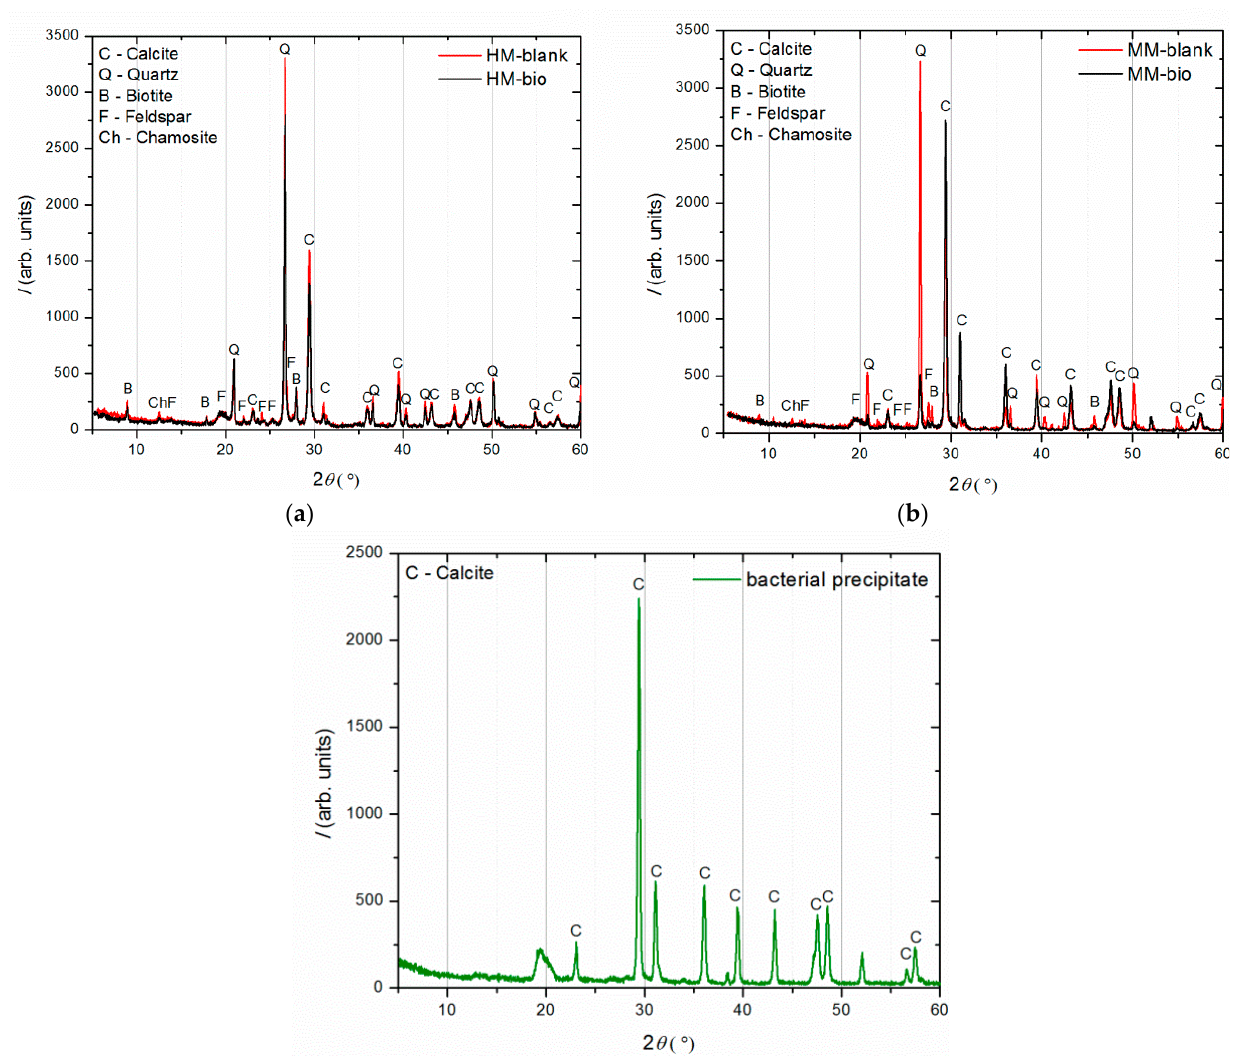
Figure 11. XRD analysis after 150 days of incubation: ( a ) HM blank and HM bio-samples comparative results, ( b ) MM blank and MM bio-samples comparative results, ( c ) sole bacterial precipitate.